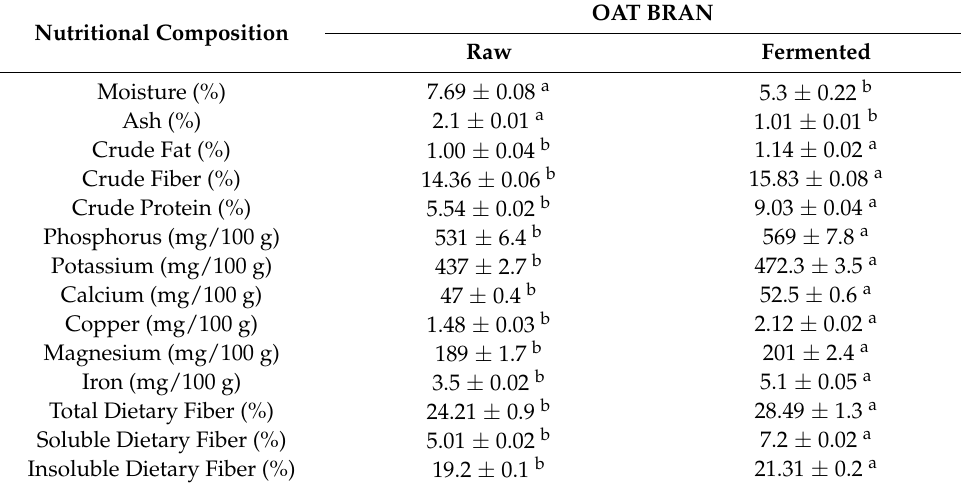
Table 1. Biochemical Composition of raw and fermented oat bran. Nutritional